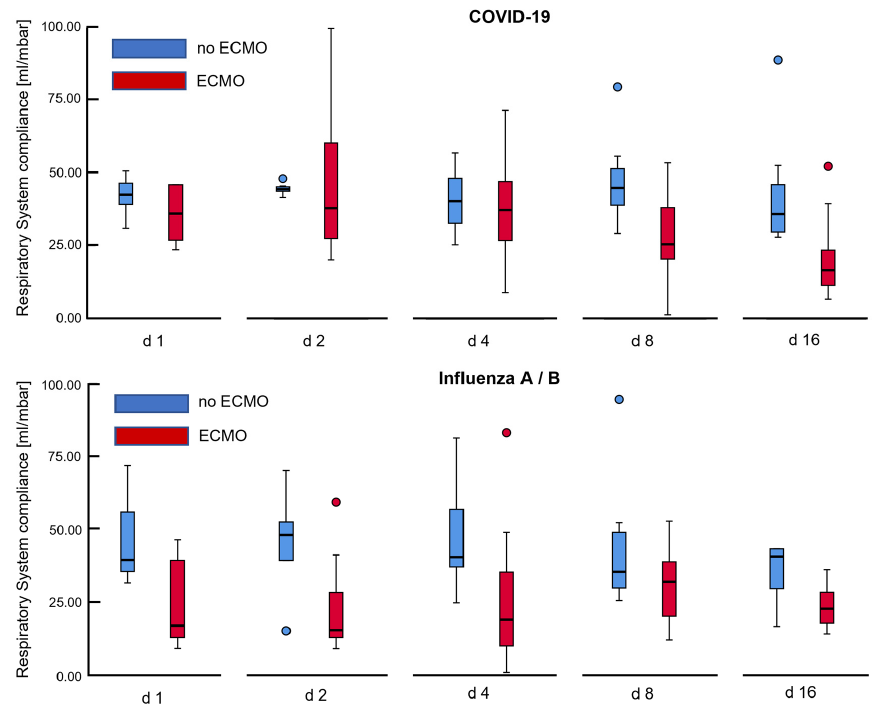
Figure 2. Development of respiratory system compliance over time for COVID ‐ 19 and Influenza associated ARDS. Histograms depict that ventilatory system compliance showed gradual decline over 2 weeks for COVID ‐ 19 patients on veno ‐ venous extracorporeal membrane oxygenation (ECMO), while compliance was severely impaired in Influenza patients from the very beginning of invasive ventilation, improving insignificantly over time. The depicted box plots mark outliers with blue and red circles. In contrast, ventilatory system compliance improved in the Influenza cohort after 7 days (28.32 mL/mbar ± 21.98 mL/mbar vs. 34.85 mL/mbar ± 29.59 mL/mbar, p = 0.10). Since the course of ARDS tended to be much shorter for Influenza patients, we cannot provide a comparison in this cohort over 15 days, as only 2 patients would have qualified for pair ‐ wise comparison between days 1 and 16. 3.4. Subgroup Analysis–ECMO vs. Non ‐ ECMO Gradual decline in compliance was particularly present in the subgroup of COVID ‐ 19 patients receiving extracorporeal support (mean loss of compliance after 7 days 19.5